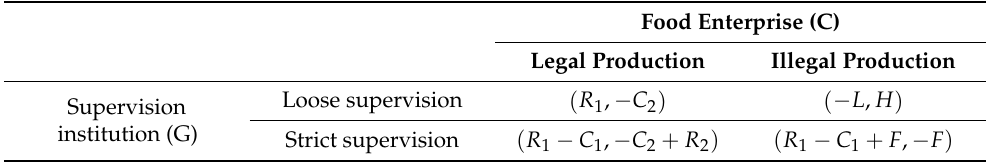
Table 2. Payoff matrix of food safety supervision